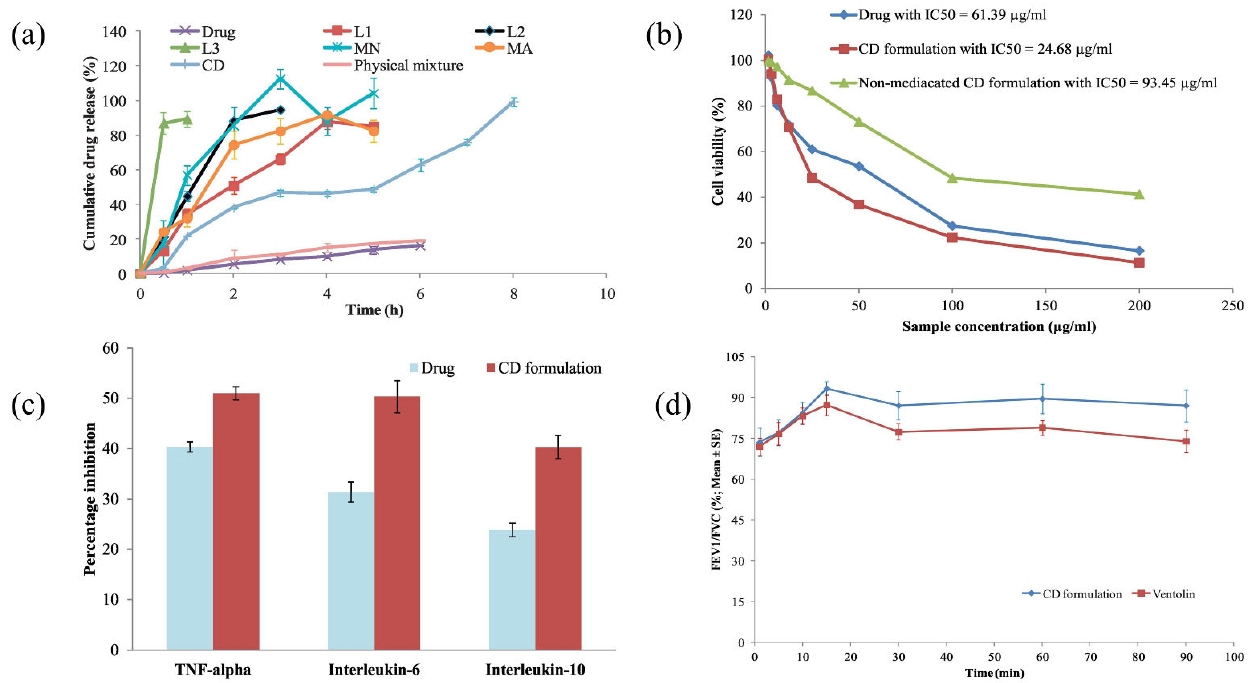
Figure 7. Design and characterization of emulsified spray-dried ALG microparticles as a carrier for the dually acting drug roflumilast ( a ) In an ethanolic phosphate buffer saline solution (30% v / v ; pH 7.4), release patterns of roflumilast and emulsified spray-dried ALG microparticles were studied. ( b ) The effects of roflumilast, a medicated CD formulation, and a non-medicated CD formulation on the proliferation of A-549 tumor cells. ( c ) TNF-alpha, interleukin-6, and interleukin-10 levels were reduced in A-549 tumor cells by roflumilast and CD formulation. ( d ) FEV1/FVC%—time curve in healthy human volunteers upon inhaling the chosen CD formulation vs. Ventolin ® HFA. Reproduced with permission from [177], Copyright Elsevier